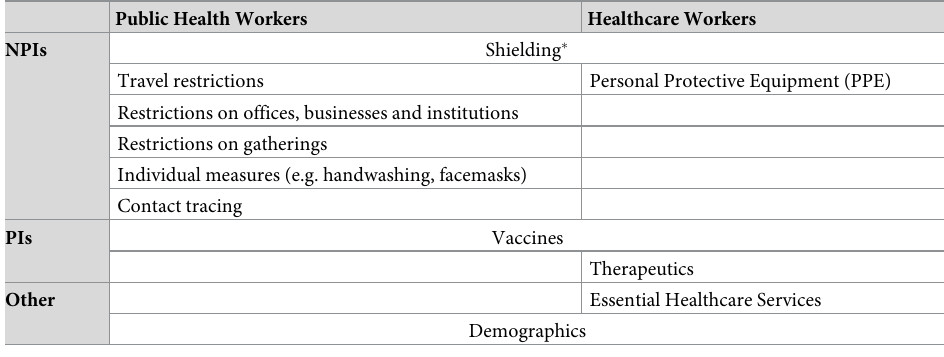
Table 1. Non-pharmaceutical and pharmaceutical interventions assessed in the